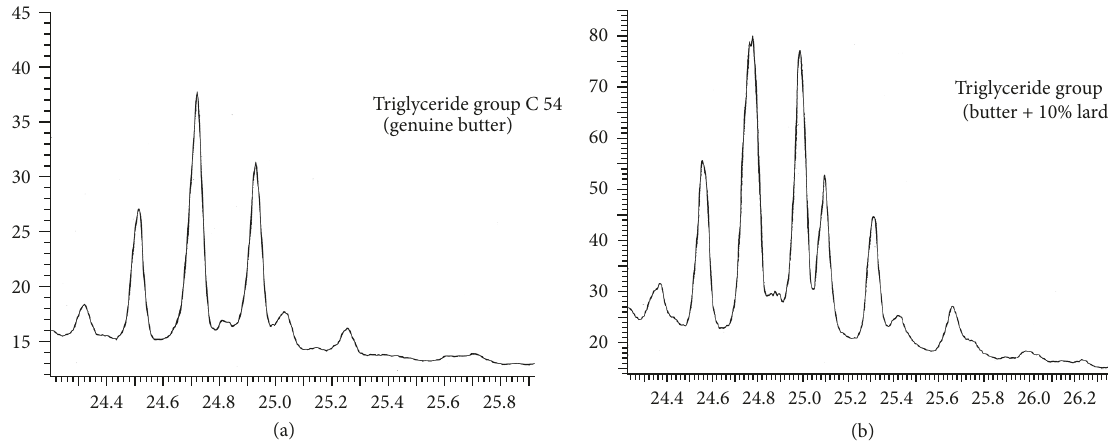
Figure 2: Gas chromatograms of the C54 family in authentic butter (a) and of the same family after the addition of 10% (w/w) lard